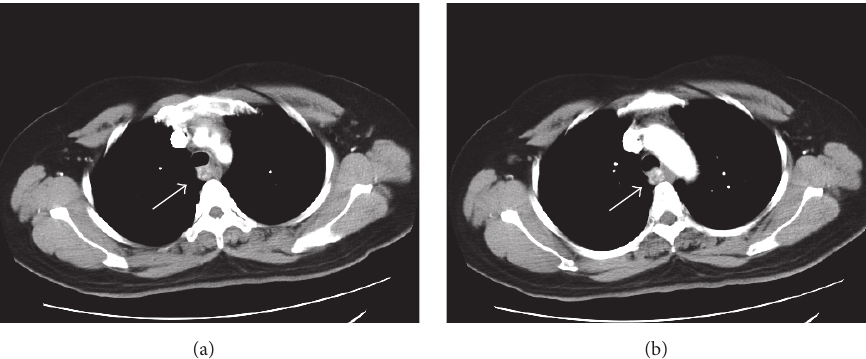
Figure 1: Thoracic computed tomography image showing an intensely enhanced lesion in the posterior superior mediastinum within the prevascular space.